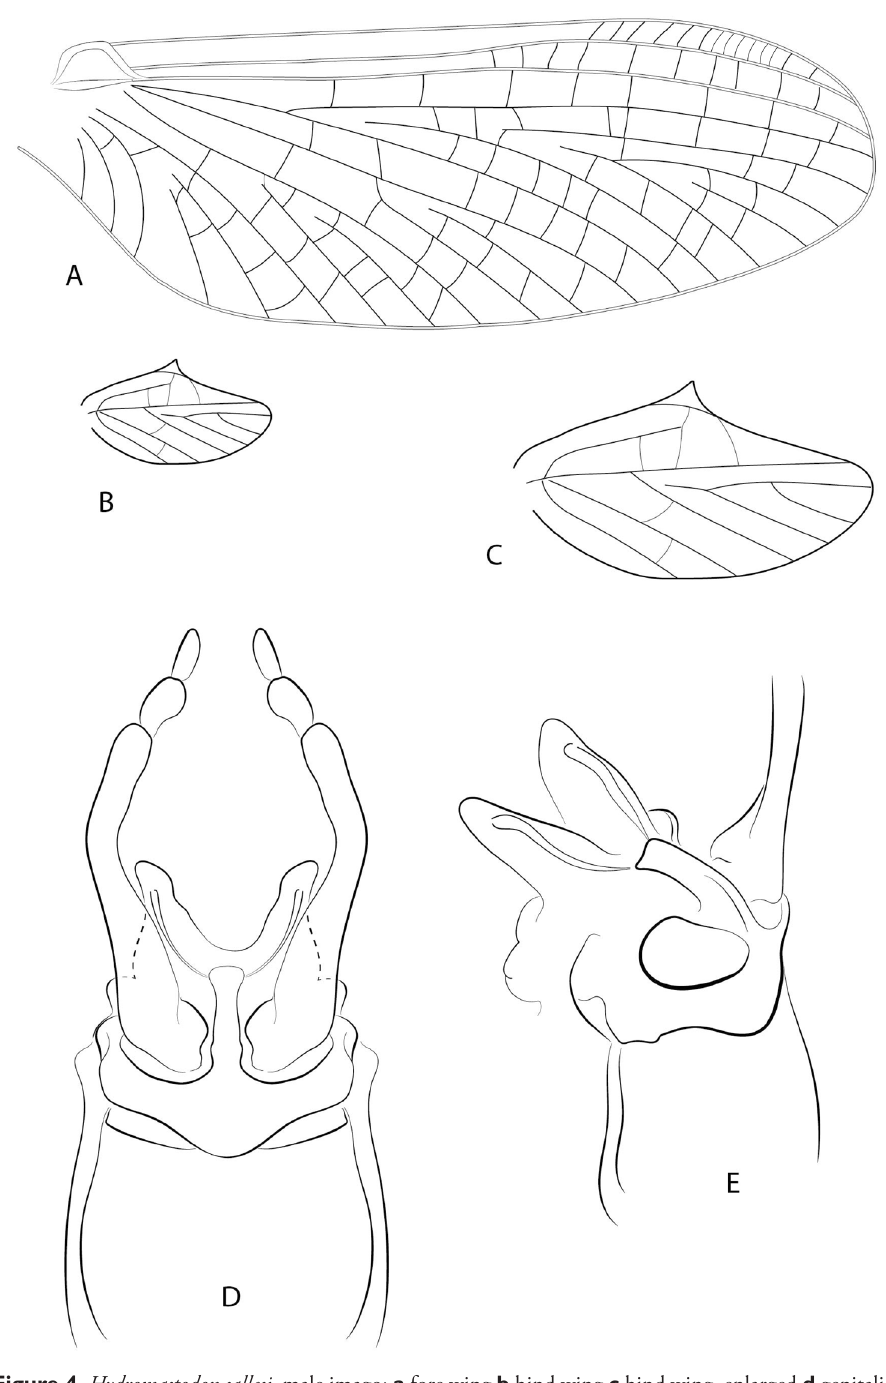
Figure 4. Hydromastodon sallesi , male imago: a fore wing b hind wing c hind wing, enlarged d genitalia, ventral view e genitalia, lateral